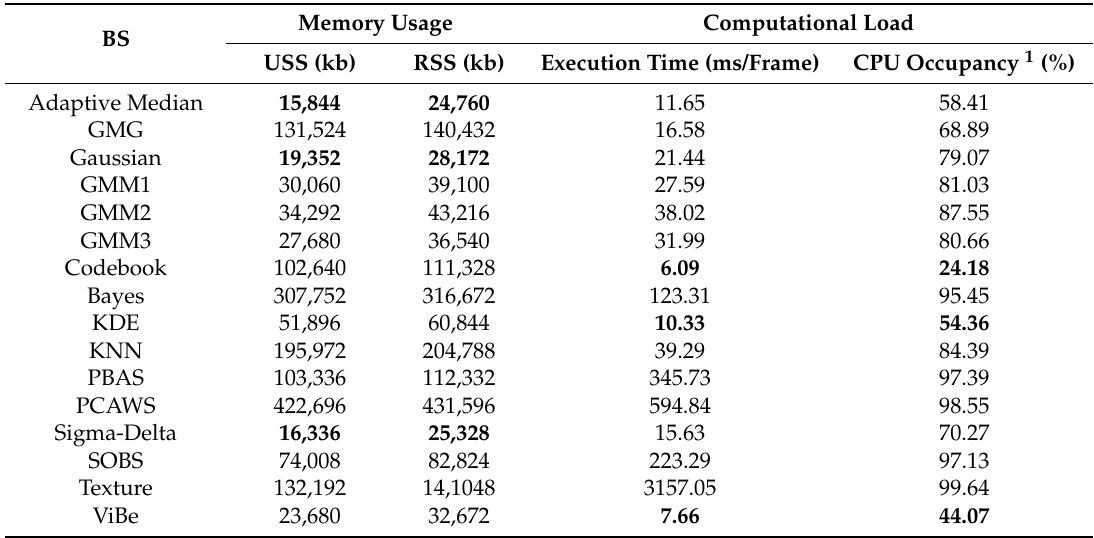
Table 21. Computational load and memory usage of the evaluated BS